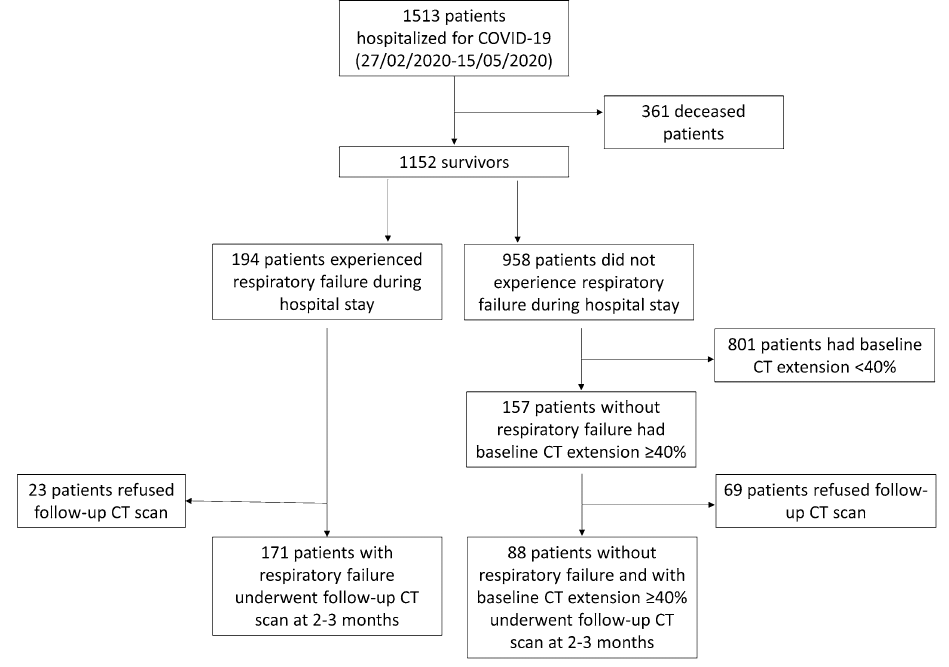
Figure 1. Flowchart representing patient enrolment.